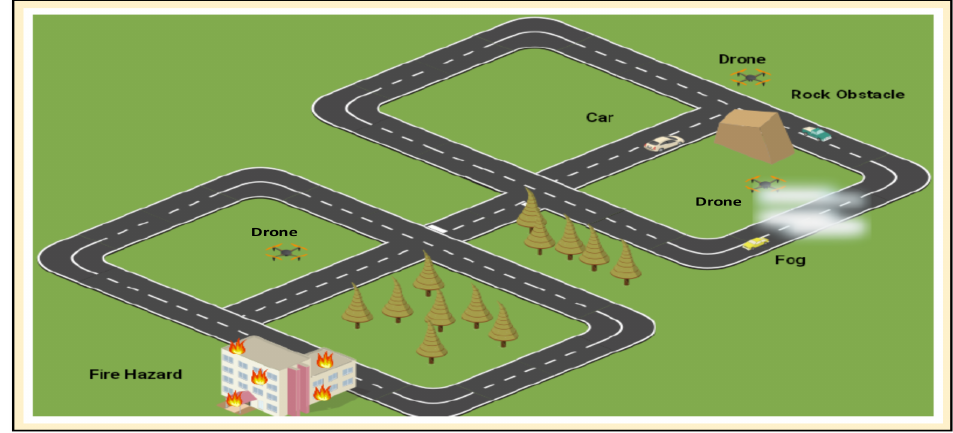
Figure 26. Sample use case scenario involving obstructed view, fog, and fire hazard.